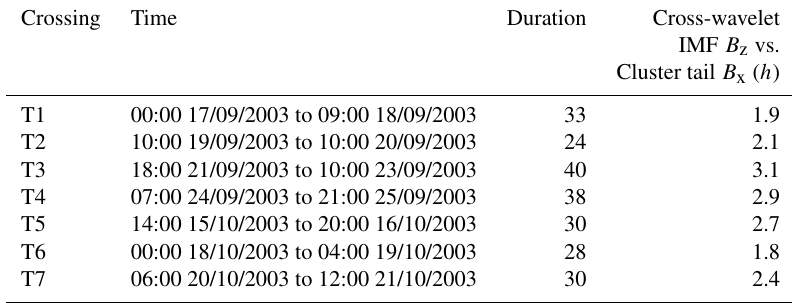
Table 1. Magnetotail crossings studied in this work (Cluster C4 spacecraft) and cross-wavelet analysis results (major periods). Crossing Time Duration